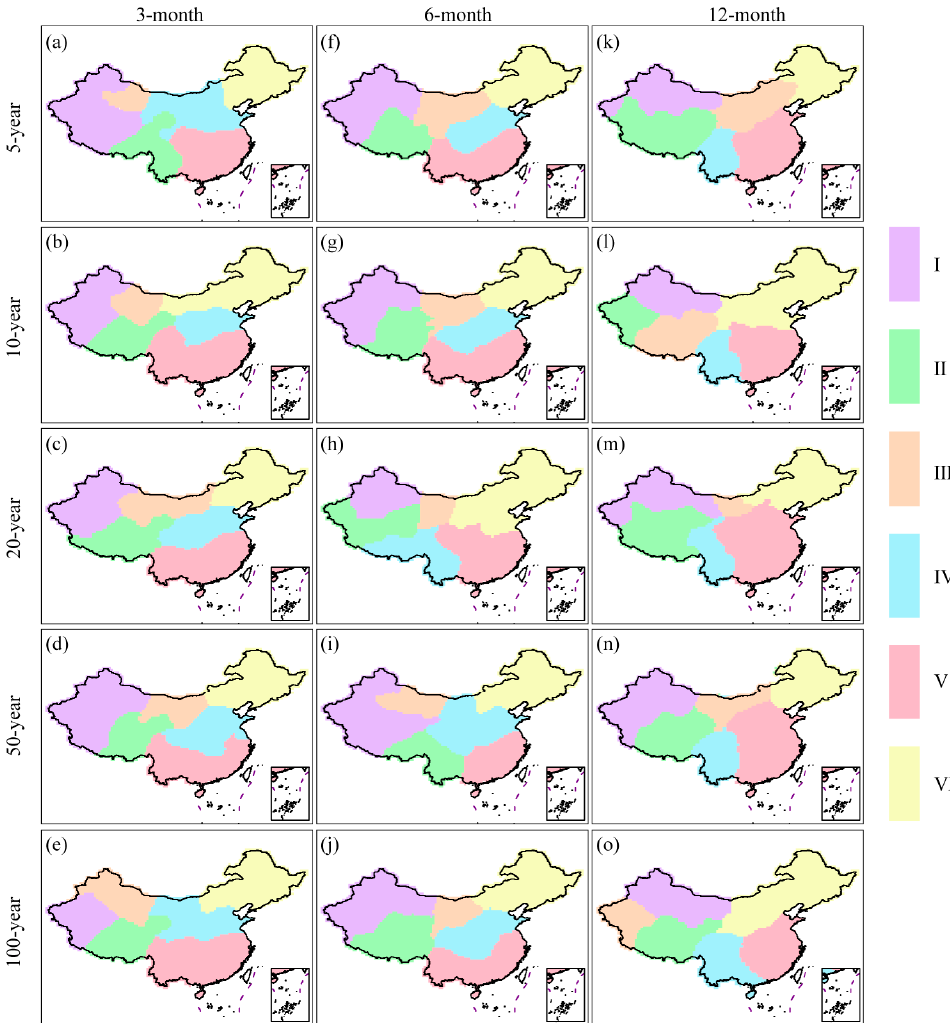
Figure 8. Drought risk regionalization across various return periods and time scales.. Specifically, ( a – e ) in each panel show the patterns of drought risk regionalization with return periods of 5-, 10-, 20-, 50-, and 100-year at the 3-month time scale; ( f – j ) in each panel depict the corresponding patterns at the 6-month time scale; and ( k – o ) in each panel illustrate the patterns at the 12-month time scale.